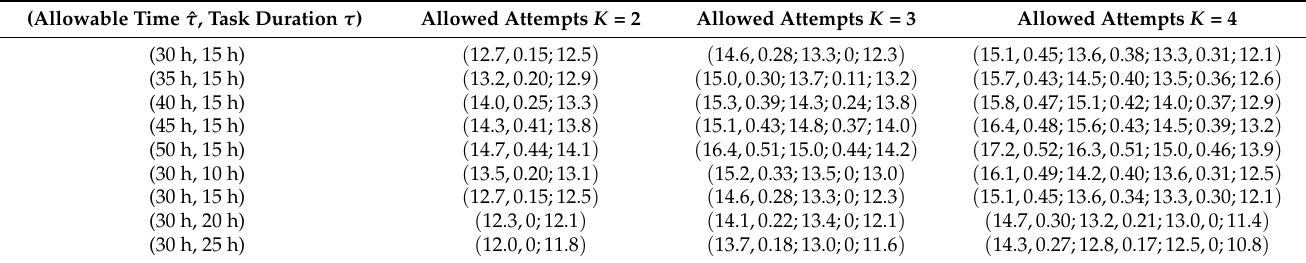
Table 2. Optimal solution under IITR given different time